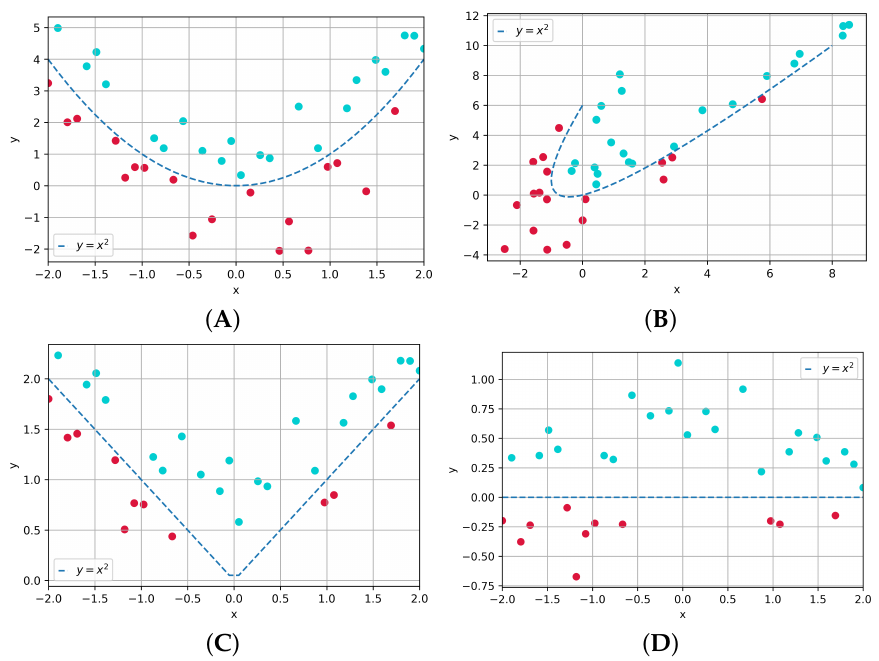
Figure 1. Comparison of the effectiveness of linear and nonlinear transformations for data classi- fication. The first figure ( A ) shows the original data distribution, the second figure ( B ) shows the distribution of the data after linear transformation, and the last two figures ( C , D ) are the distribution of the data after nonlinear